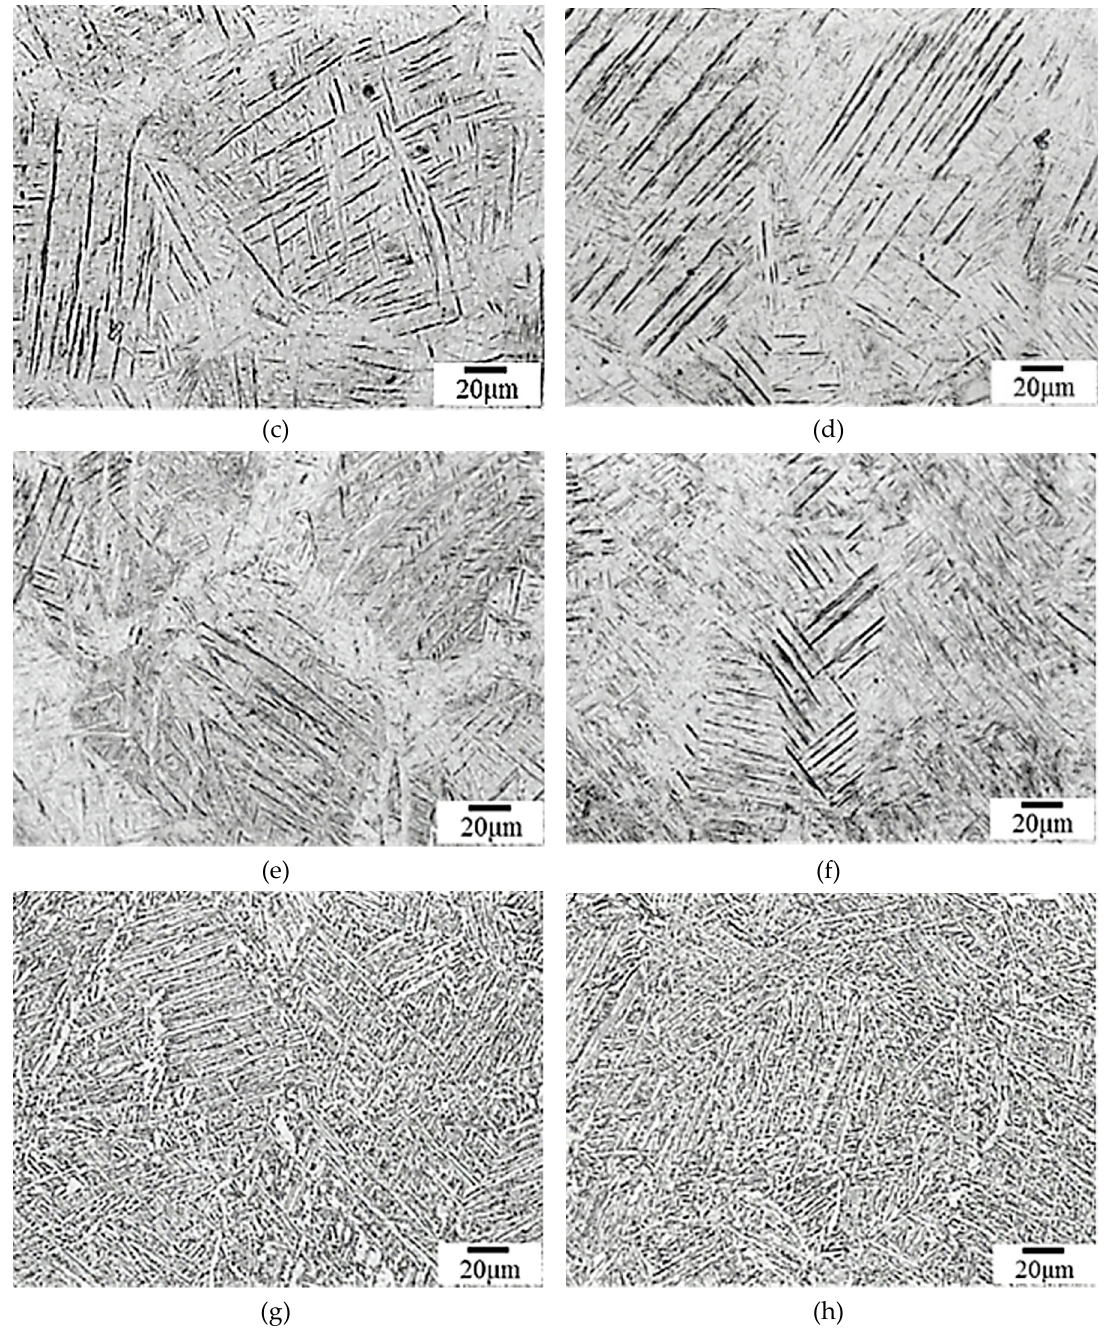
Figure 4. Microstructures in the ( a ) normal direction of as-SLM Ti-6Al-4V (AS), ( b ) side direction of AS, ( c ) normal direction of 400-AC, ( d ) side direction of 400-AC, ( e ) normal direction of 600-AC, ( f ) side direction of 600-AC, ( g ) normal direction of 800-AC, and ( h ) side direction of 800-AC.